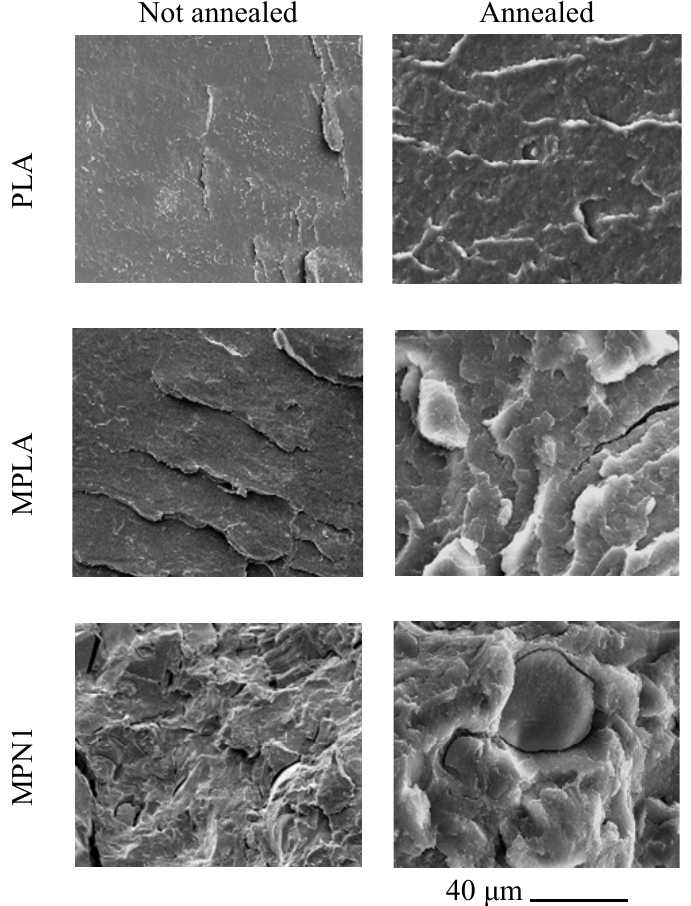
Figure 4. SEM images of cryogenic fracture surfaces of PLA, MPLA, and MPN1 before and after annealing.